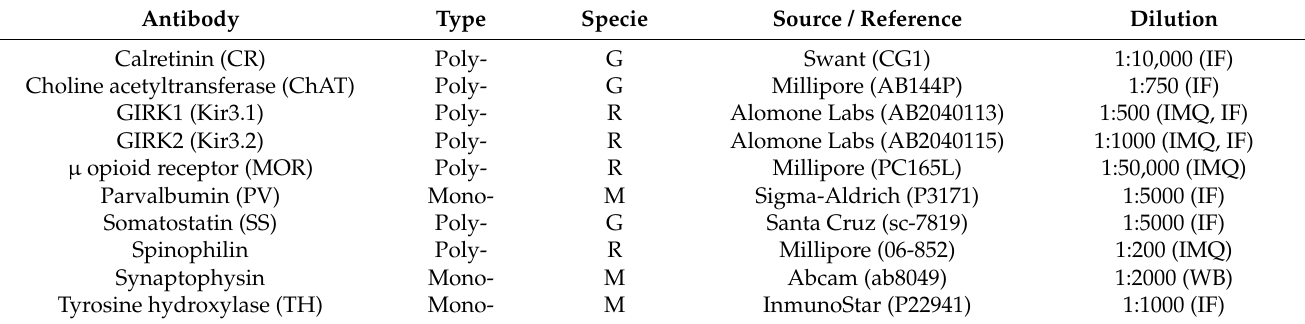
Table 1. Primary antibodies used for immunohistochemistry and western